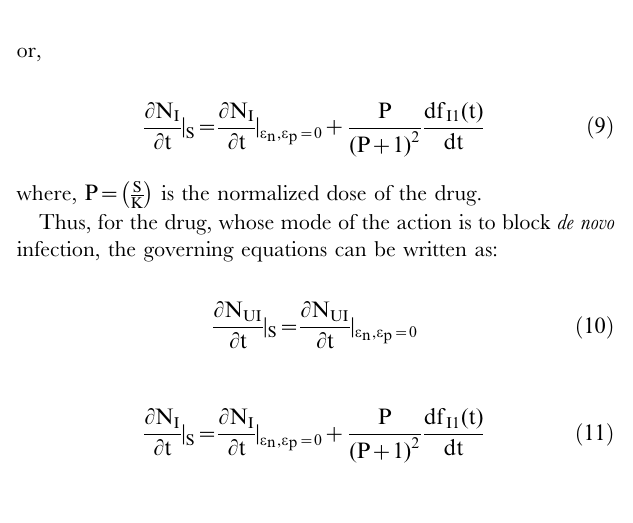
Figure 2. Perturbation in the first phase shows two steady states of the infection. Dynamics of the (A) uninfected cells, (B) infected cells, and (C) the viral load when the system was perturbed by the dose P of the drug that blocks new infections during the time period t=0 to t=180 day. Dynamics of the (D) uninfected cells, (E) infected cells, and (F) the viral load when the system was perturbed by the dose P of the drug that blocks virus production during the time period t=0 to t=180 day.